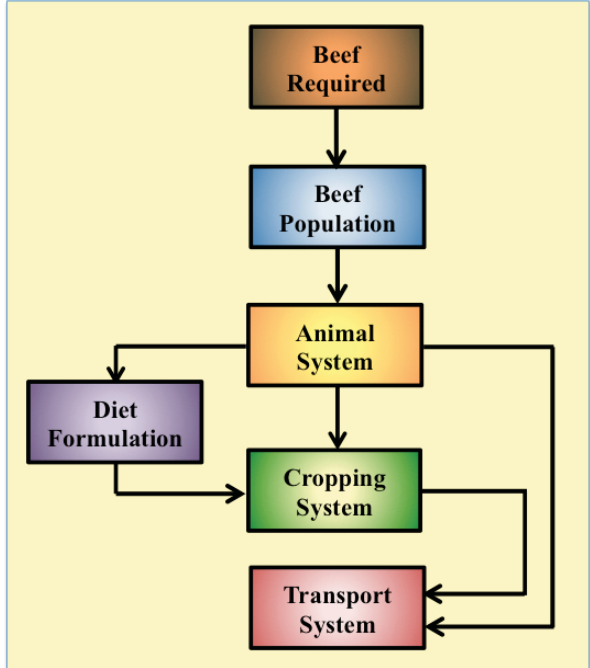
Figure 1. Simplified schematic representation of the sub-systems within the environmental impact